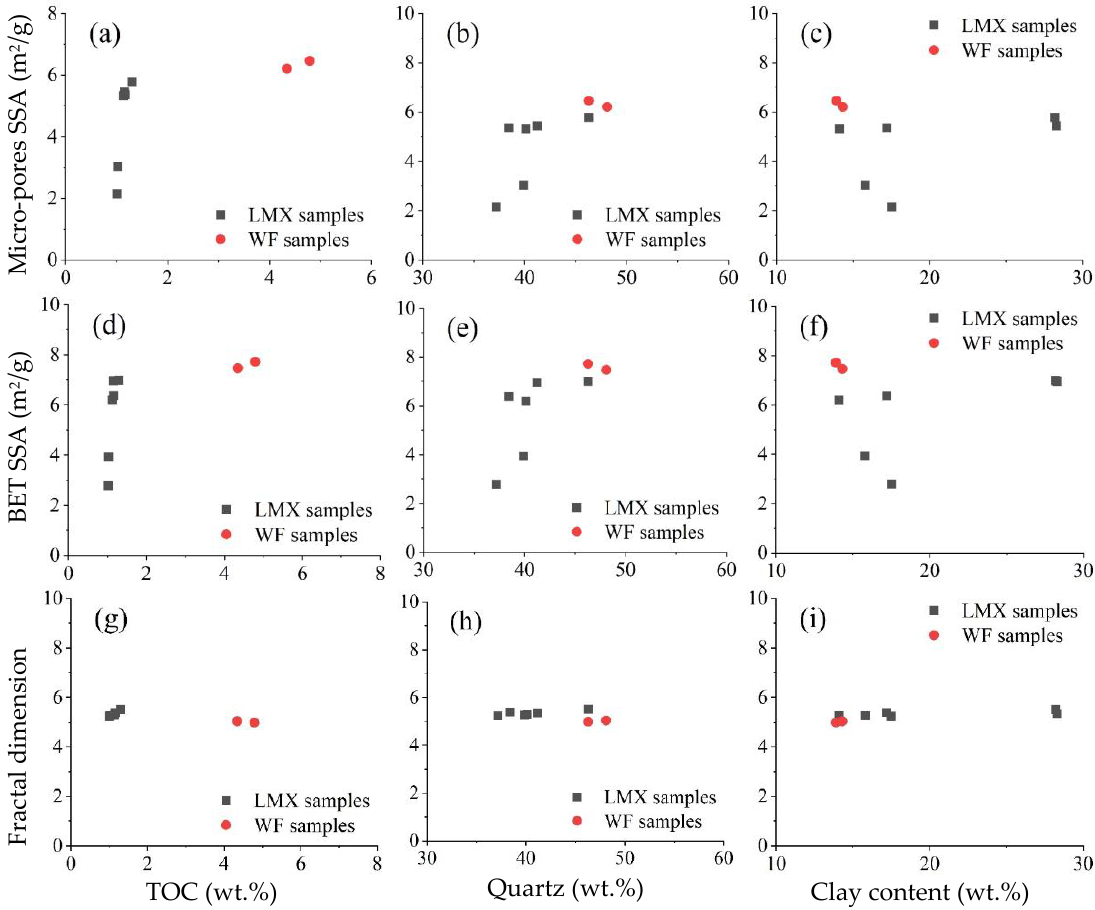
TOC (wt.%) Quartz (wt.%) Clay content (wt.%) Figure 10. Relationships between shale pore structure parameters and TOC ( a , d , g ), quartz ( b , e , h ), and clay minerals ( c , f , i ).